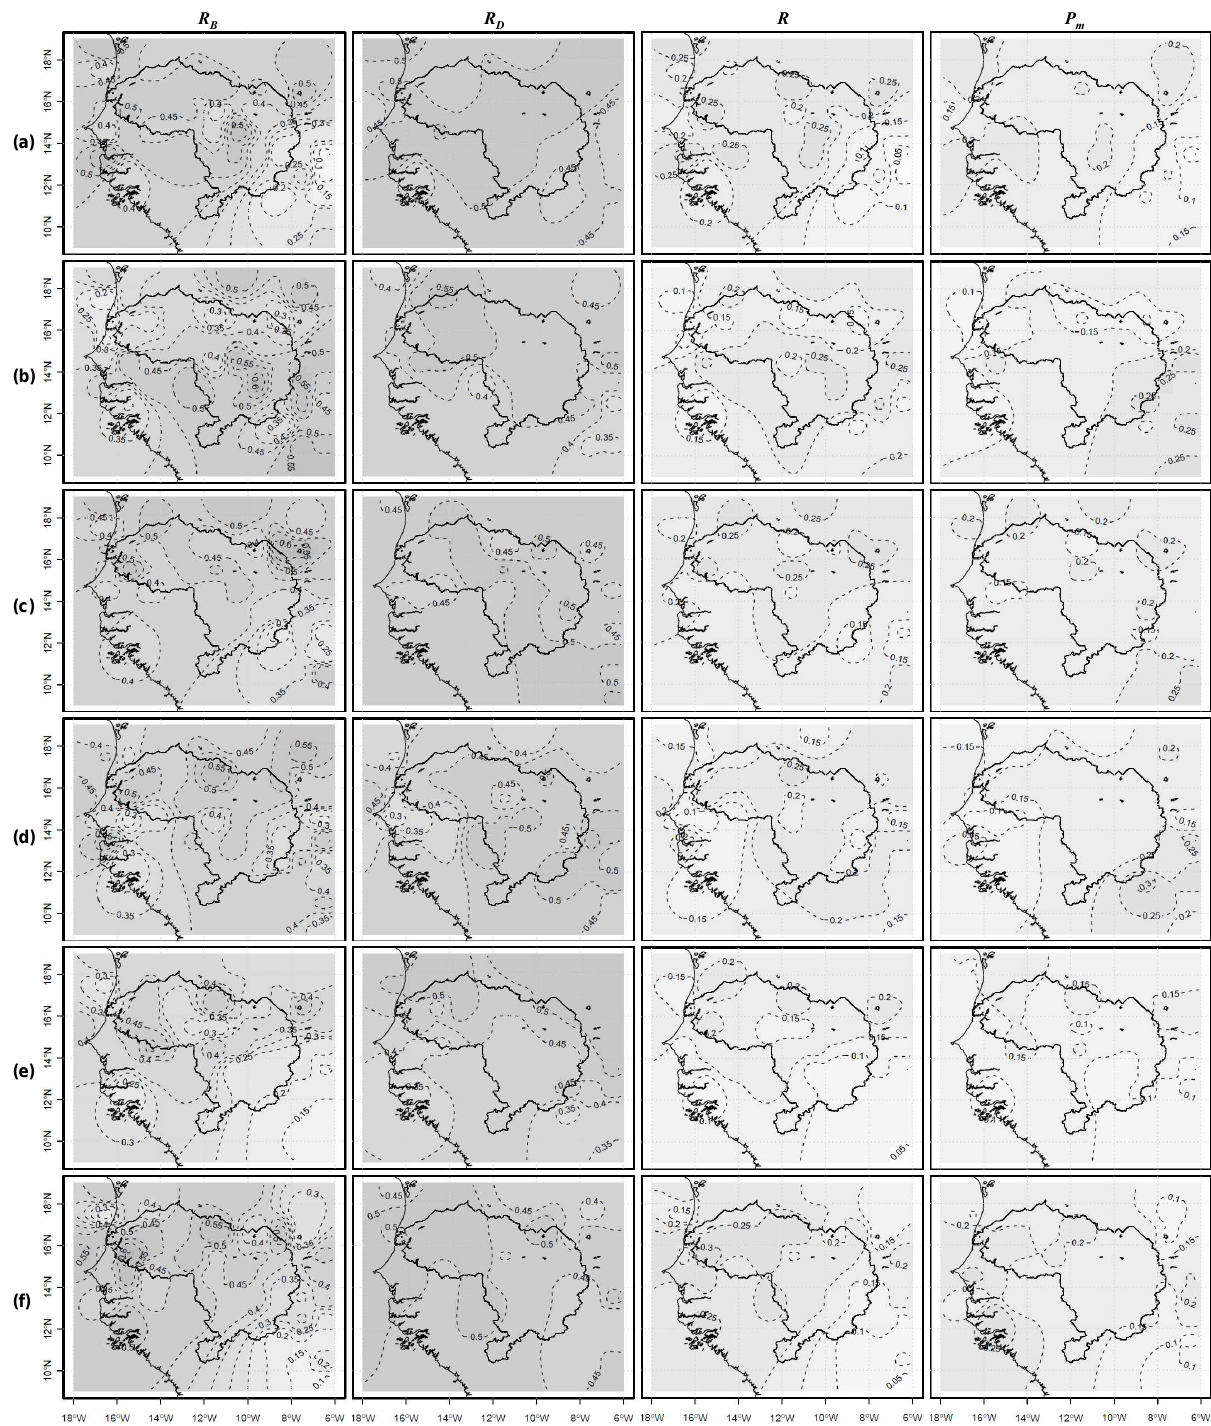
Fig. 2. Maps of RCM reliability factors R B , R D , R and Pm : (a) GKSS/CLM, (b) INM/RCA, (c) KNMI/RACMO, (d) METNO-HC/HAD, (e) MPI/REMO, and (f)